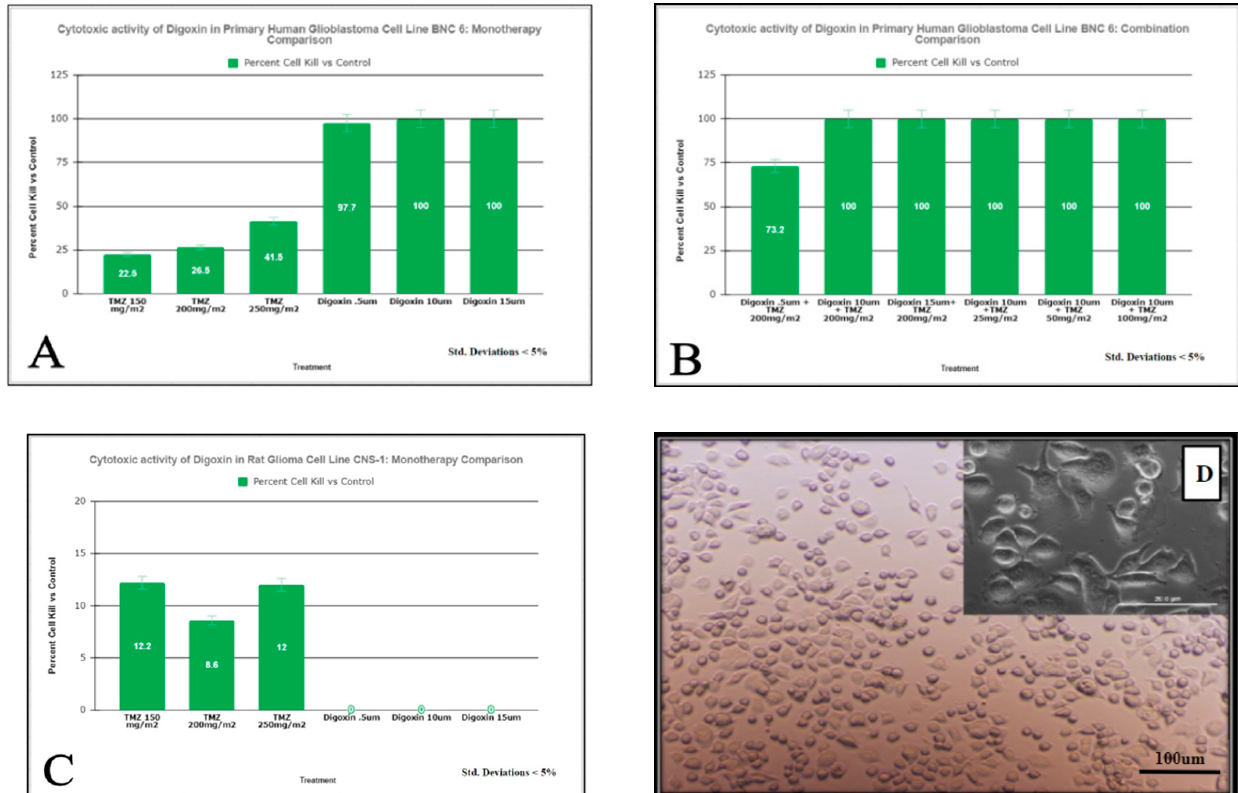
Figure 2. Measurement of cell viability following TMZ and Digoxin Monotherapies and Combination therapies on BNC6 (Panels ( A , B )) and CNS-1 cells (Panel ( C )) assessed by MTT Assay. Cells were exposed to a one-hour pulse to the combinations of drugs listed above followed by a 24-h incubation period. MTT was added and cell viability was measured as described in “Materials and methods. Results are expressed as % of the control (98% kill ETOH). Values are the average of 8 replicates at p < 0.05. Panel ( D ) displays monolayer cell culture of primary BNC-6 cells with lowest dose TMZ monotherapy.